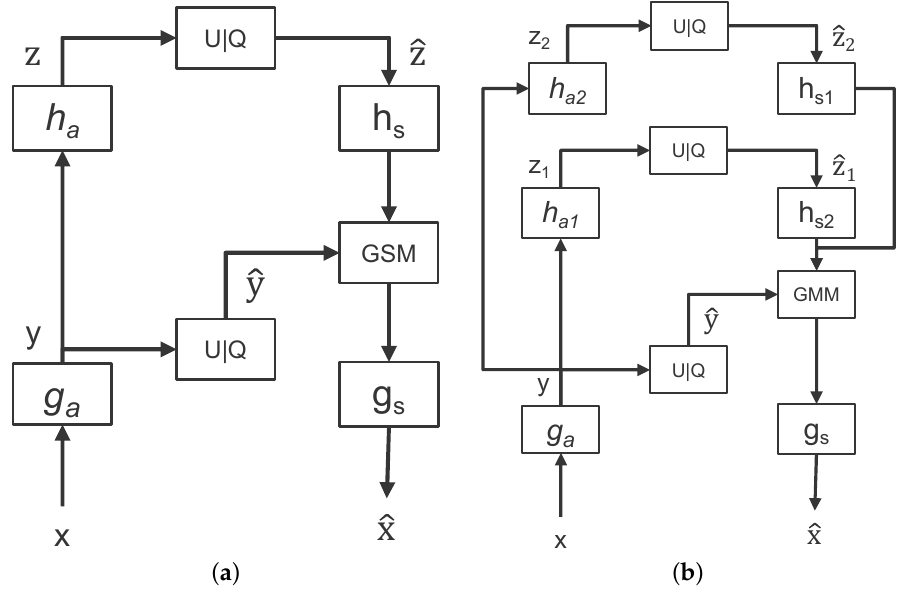
Figure 2. ( a ) Hyperprior [56]. ( b )